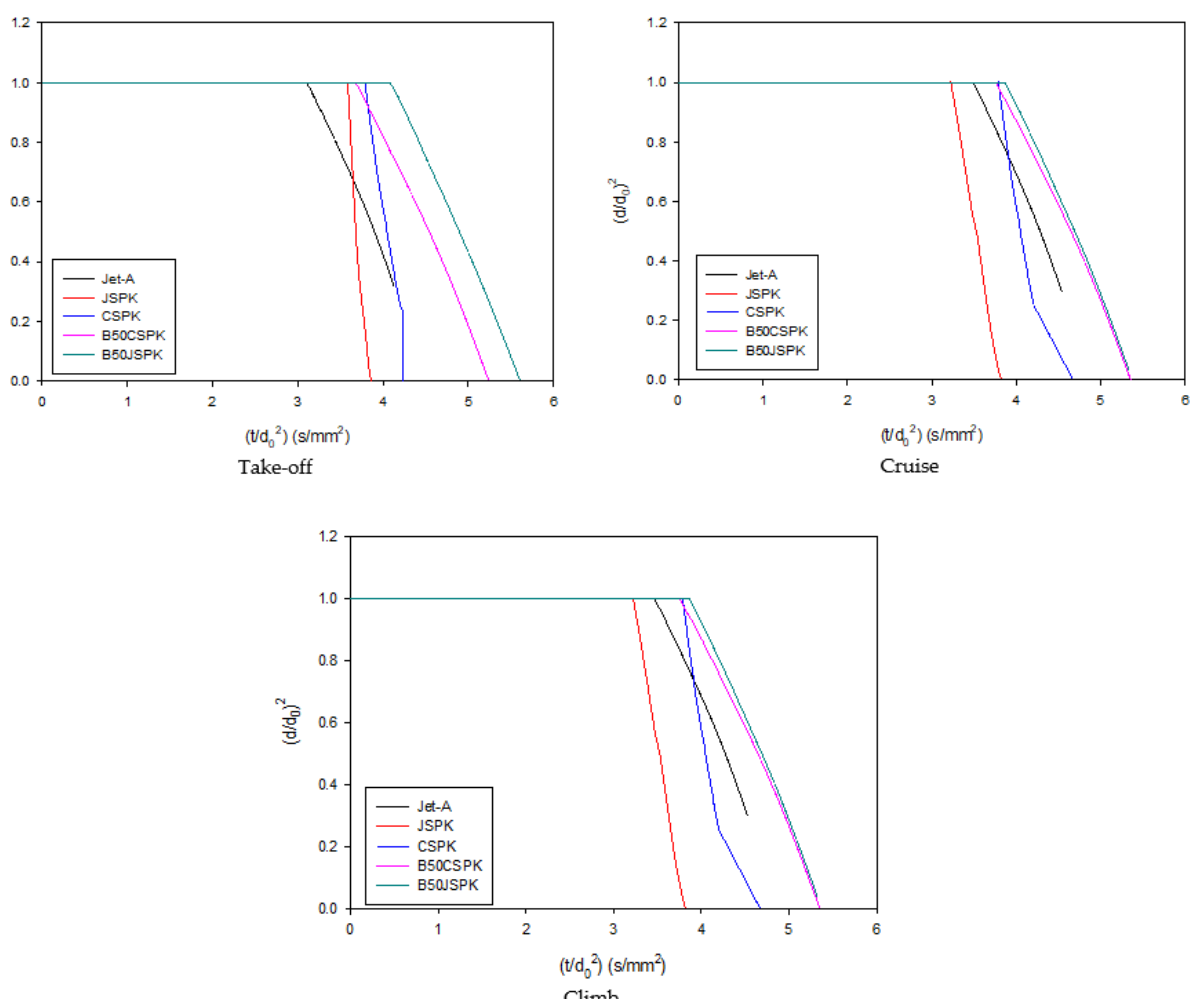
Figure 6. Comparison of d 2 law curve of biofuels and Jet–A at Take-off, TOC, and Cruise.